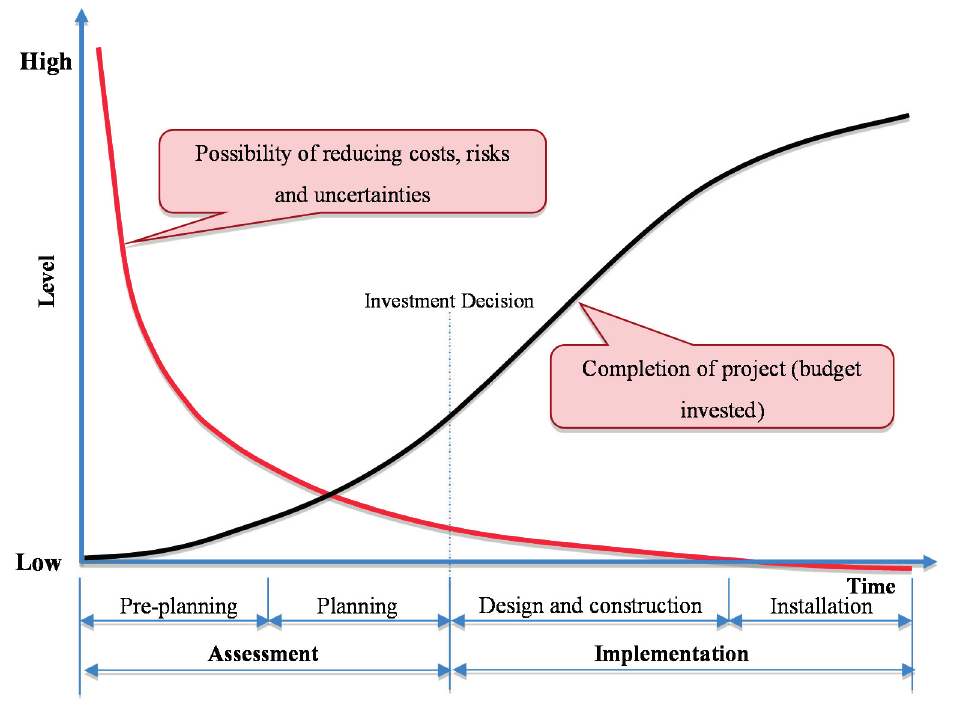
Figure 4. Control of project factors (costs, risks and uncertainties). Adapted from